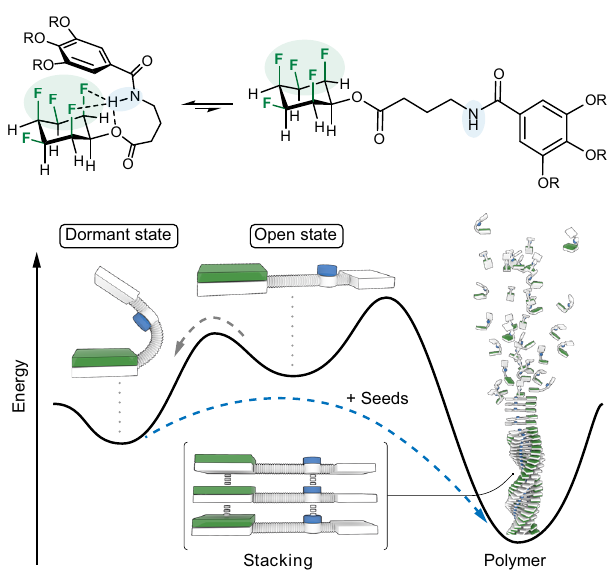
Fig. 1 General structure of monomers and energy landscape of supramolecular polymerization. Top: general molecular design of the key monomer in a representative folded and the unfolded state. Bottom: schematic illustration of the partial energy pro fi le of LSP. Folding of a monomer into dormant states inhibits spontaneous aggregation, whereas seeds can initiate